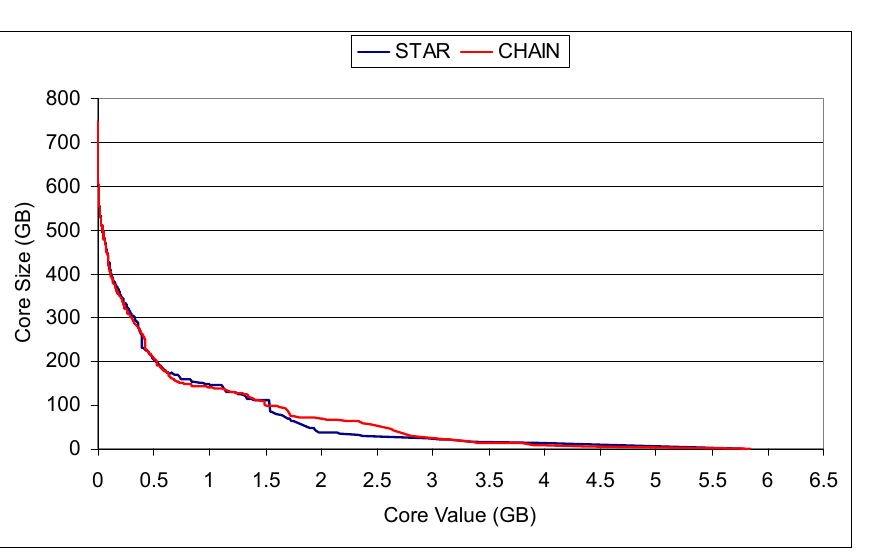
Figure 8. The k-cores and their (deduplicated) size for WL1 workload using CHAIN and STAR